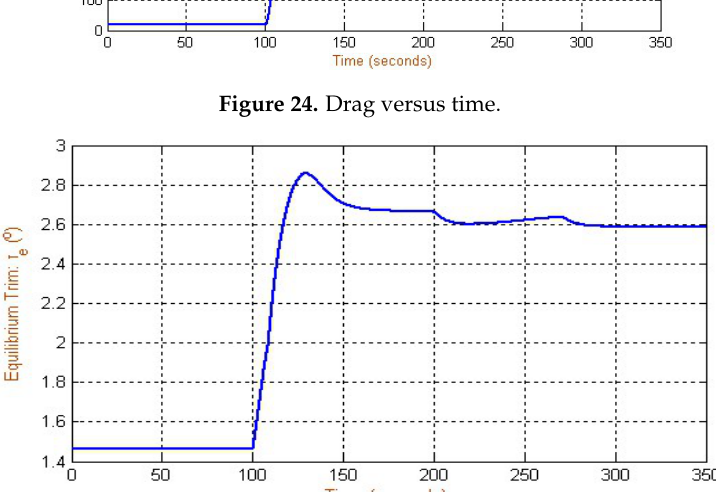
Figure 25. Equilibrium trim versus time.